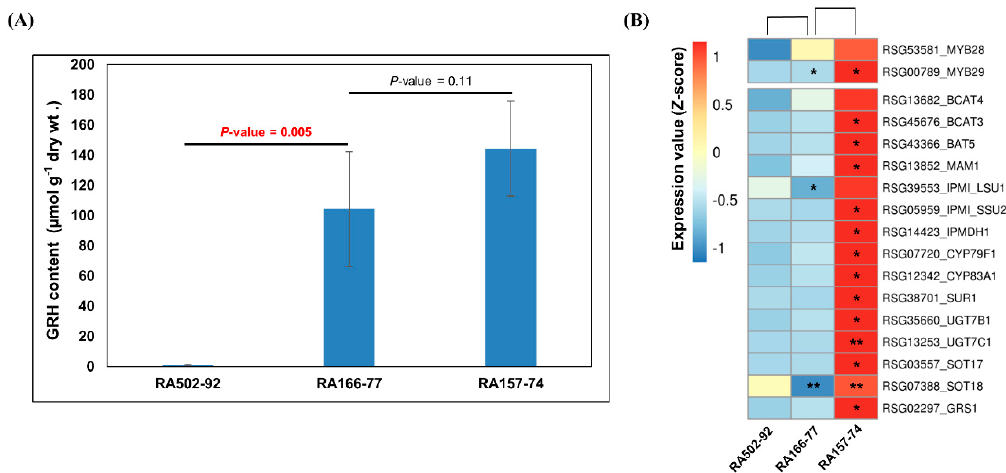
Figure 8. GRH content and analysis of DEGs involved in the GRH biosynthesis in radish roots. ( A ) Statistical analysis of GRH contents. ( B ) Heat map of DEGs. Expression values (qRT-PCR) of individual genes were normalized by Z-score and scaled per row (i.e., per gene) for the visualization of the expression peaks of genes among the accessions. Significant differences are indicated as * p < 0.05 and ** p < 0.01 (Student’s t test).